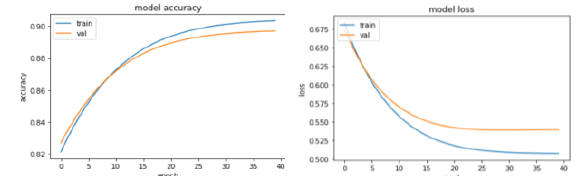
Figure 10. U-net model training and validation accuracy of each epoch.